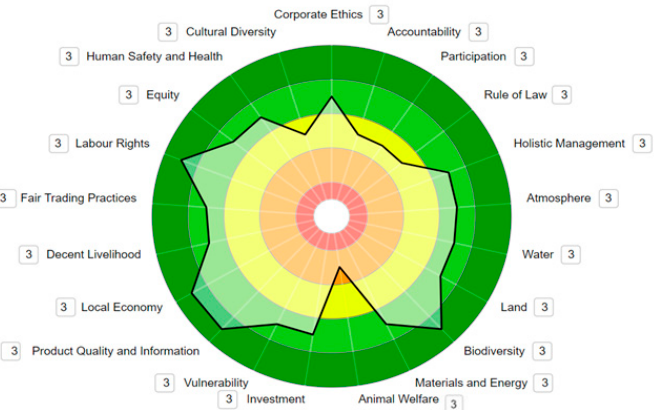
Figure 8. SAFA assessment result of the start-up as spider graph. The number near indicators suggest the data quality according to Table 4, and also, the colour in the circles represent the range score. As reported in Table 3, the colour means the performance score: Dark green: Best; light green: Good; yellow: Moderate; orange: Limited; red: Unacceptable. The implementation of old varieties leads to a high score in biodiversity indicators, and the involvement of local community fosters green colour related to local economy indicators.